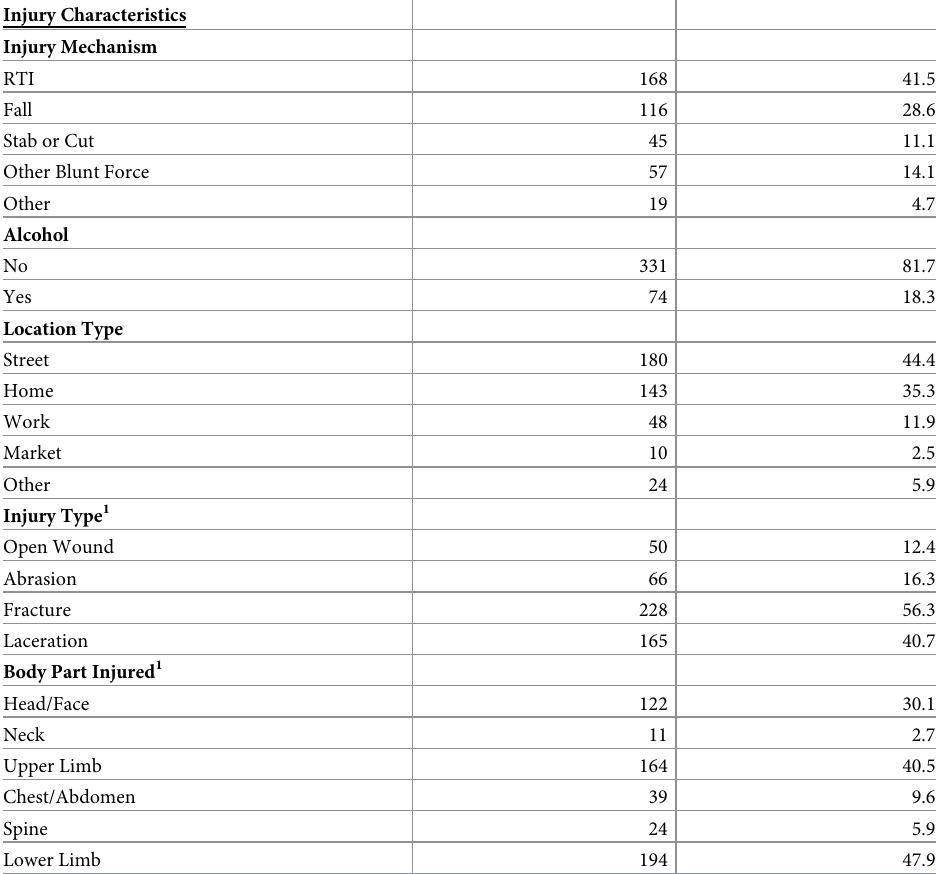
Table 2. Injury characteristics: Frequencies and